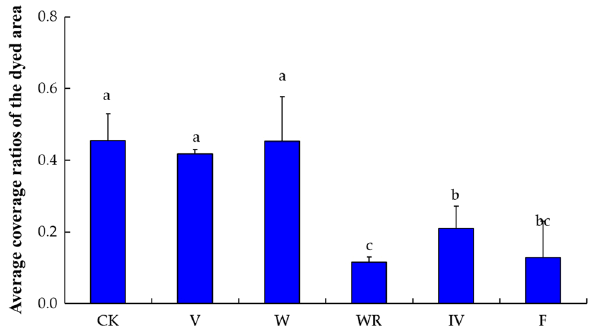
Fig. 4 Average coverage ratios of the dyed area for different near-sur- face fissures. (CK) No fissures, (V) V-type fissure, (W) W-type fis- sure, (WR) W + rocks-type fissure, (IV) inclined V-type fissure, (F) conduit